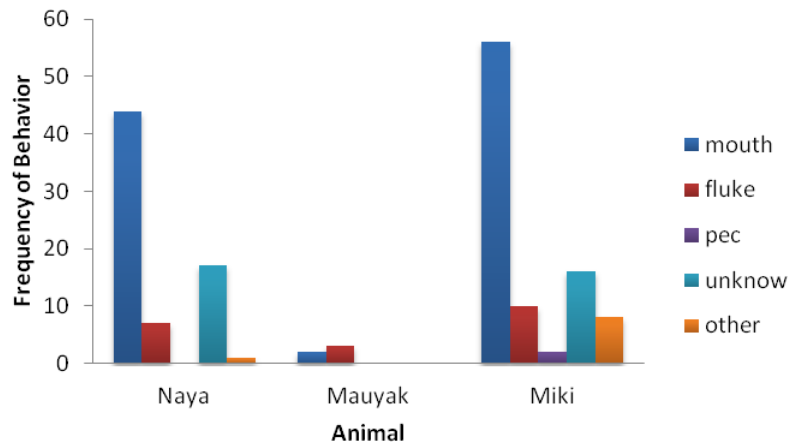
Figure 4. Body part used by each animal to pop the bubble